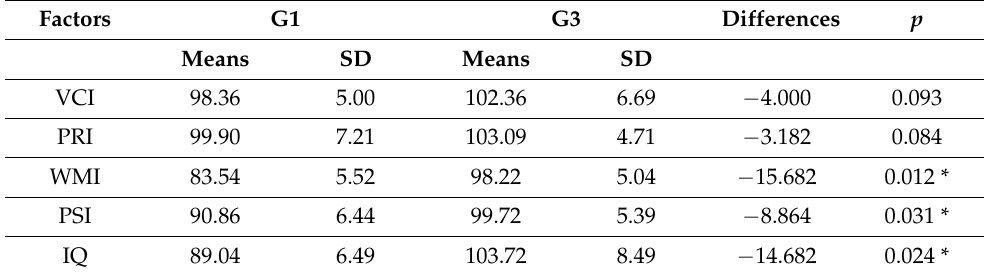
Table 3. Post hoc comparisons between Groups 1 and